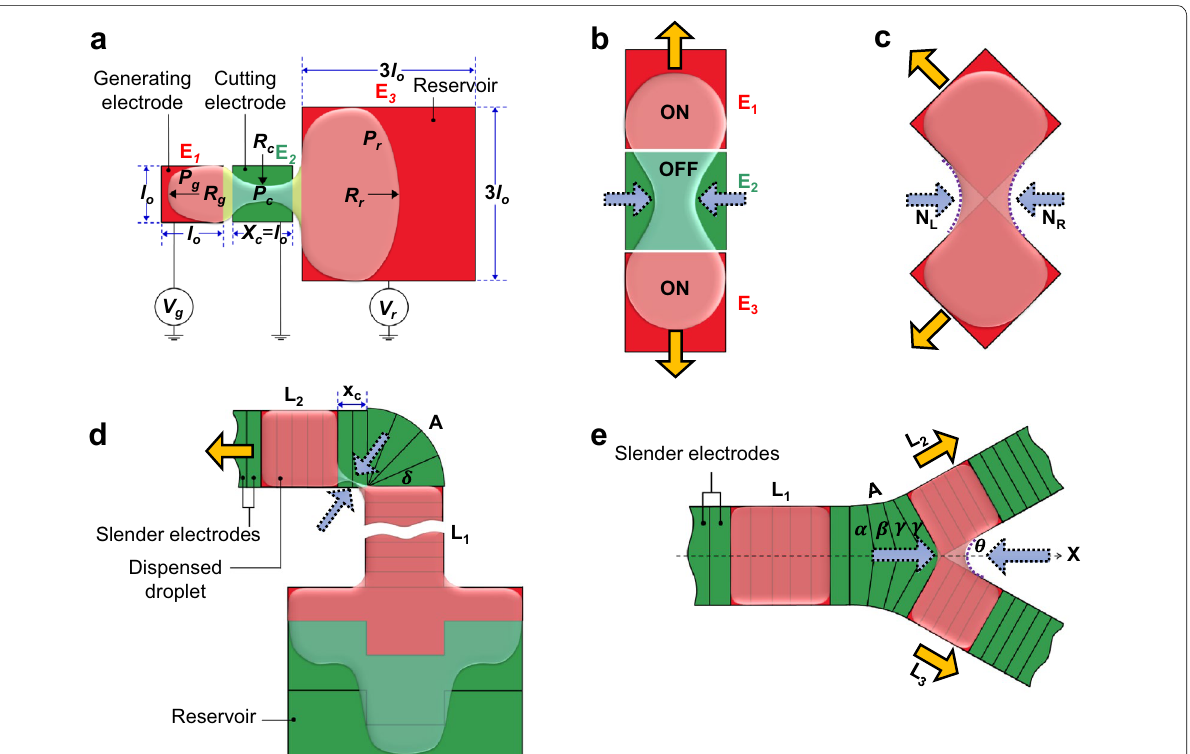
Fig. 1 a Droplet generation in conventional reservoir. Here, l o is the representative electrode dimension and x c is the cutting length. P and R denote the pressure and radius of curvatures respectively with the subscripts referring to particular electrodes. b Droplet splitting using conventional approach. Yellow ( solid ) and blue ( dotted ) arrows indicate electrowetting and de-wetting forces respectively. c Ideal droplet splitting concept with the yellow and blue arrows as representative of electrowetting and de-wetting forces. N L and N R denote the left and right meniscus at the junction between the diamond shaped electrodes. d Droplet generation in L-junction with ‘L 1 ’, ‘L 2 ’ being the linear segments whereas ‘A’ as the angled section. δ is the angle of each slender electrodes in section ‘A’. e Droplet cutting in Y-junction. Linear sections L 1 , L 2 and L 3 are composed of straight slender electrodes whereas arc section A is composed of slender electrodes with angles α, β and γ. The dashed line , X denotes the horizontal axis towards the initial droplet